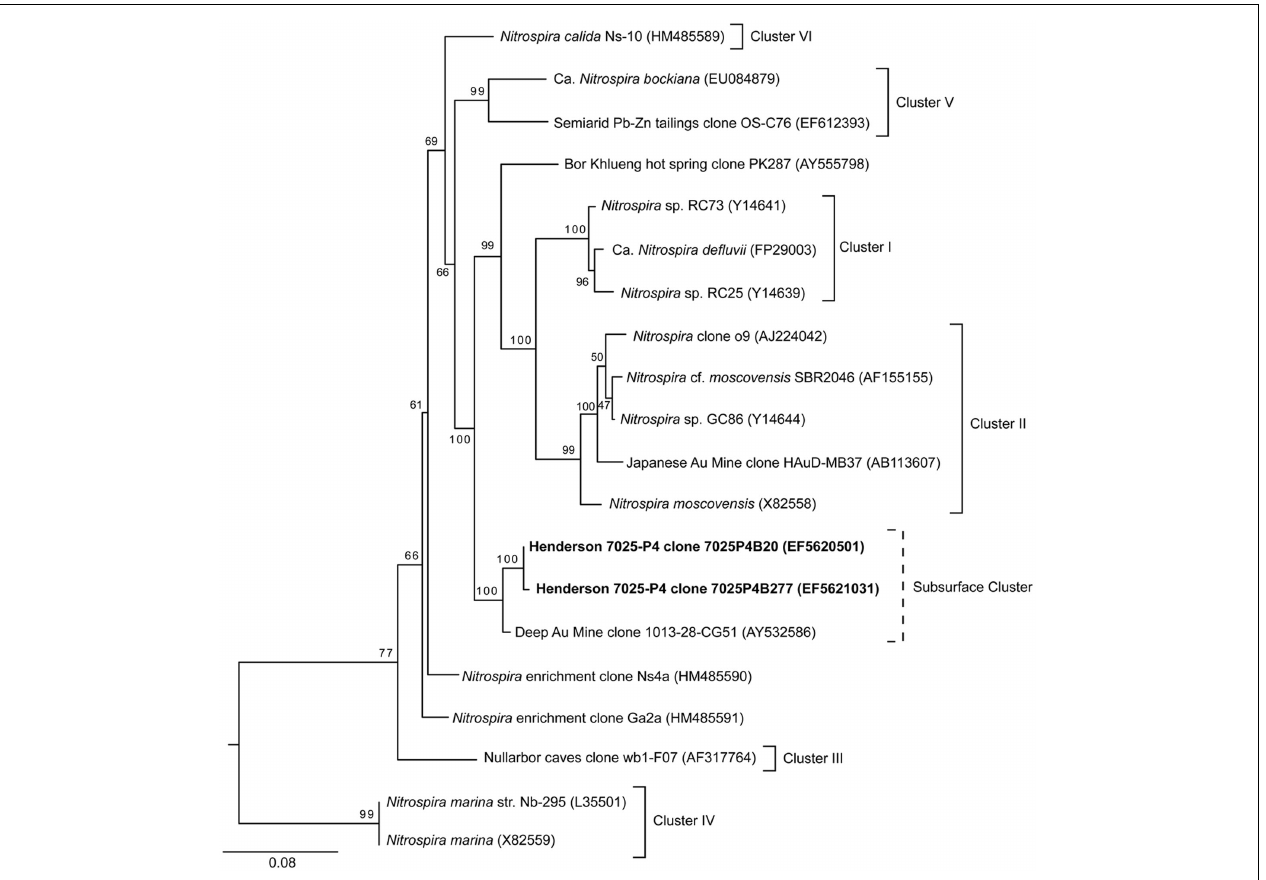
maximum-likelihood tree in which clusters I–VI are marked (after Daims et al., 2001; Lebedeva et al., 2011).The two sequences retrieved from Henderson Mine do not group in a known cluster, but bootstrap values support their association with a South African Au Mine clone, which may represent a new subsurface Nitrospira cluster. Bootstrap values are shown, and the scale bar represents 0.1 substitutions per site.The proteobacterial outgroup has been removed for